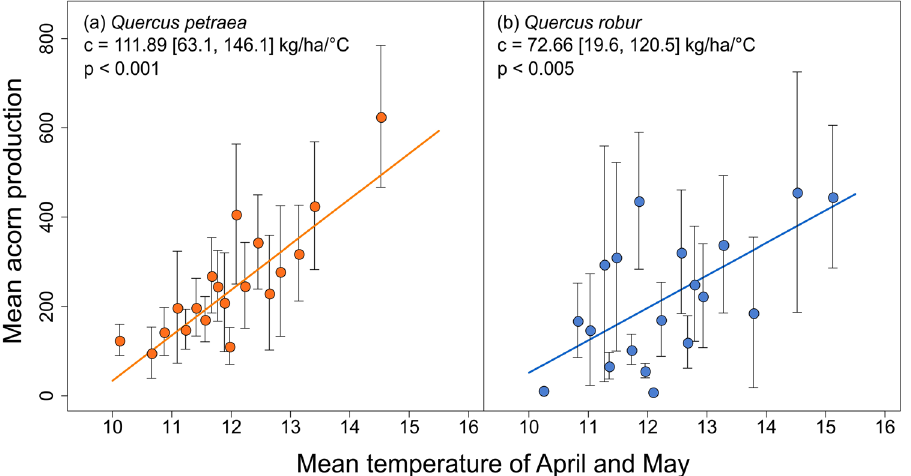
Figure 2. Responses of seed production to spring temperature for both Quercus petraea and Quercus robur . Changes in acorn production per population and per year (M Acorns ) for Q . petraea ( a ) and Q . robur ( b ) according to mean spring temperature. For both species, acorn production data for all populations and all years were binned into 19 temperature classes of approximately the same size, 14 for Q . petraea and 6 or 7 for Q . robur . Mean acorn production per bin is correlated with the temperature class median, the standard errors are indicated for each dot. The slope of the regression line and its 95% confidence interval, calculated from a linear mixed-effects model [4], and the coefficient of determination ( R 2 ) between the model [4] and the binned data are given for each